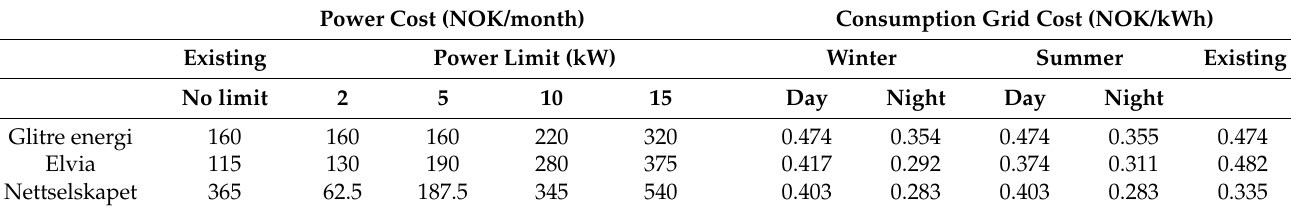
Table 6. The analyzed grid rent